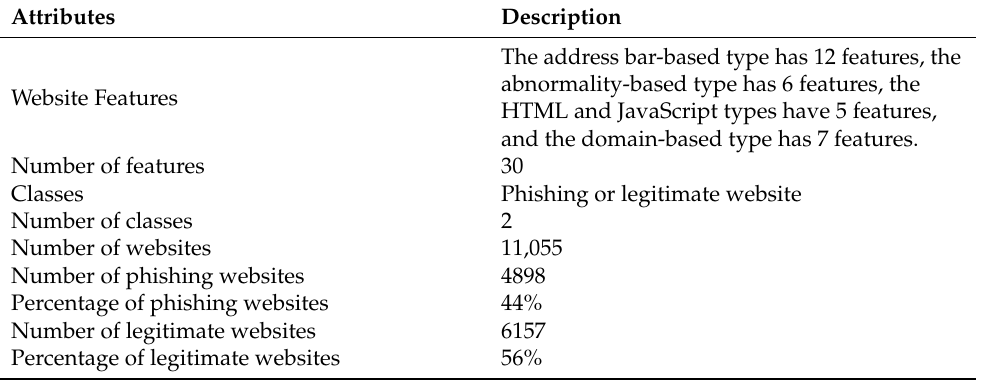
Table 1. The fundamental attributes of the dataset of phishing websites utilized in the